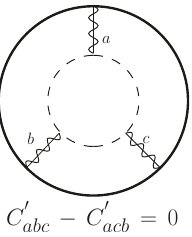
Figure 10 . The one-loop vertex corrections to vanishing.